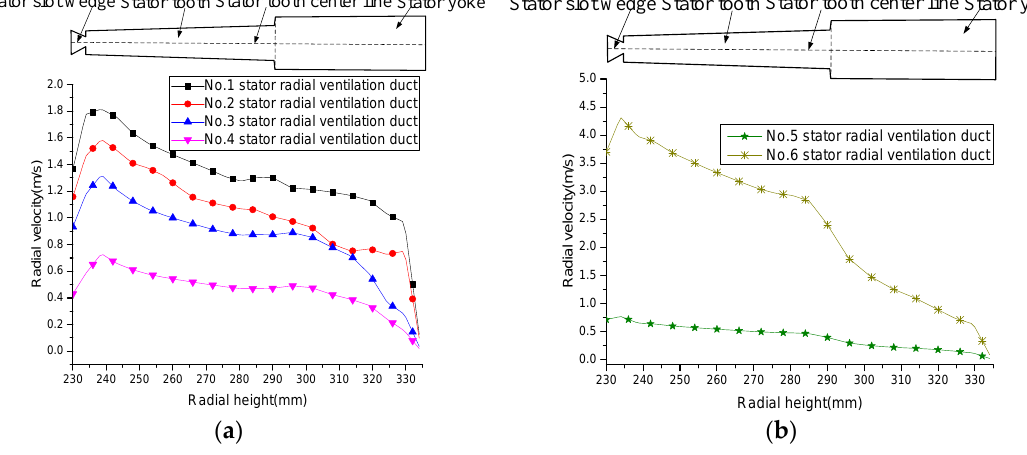
Figure 7. The changing trend of the radial flowing velocity of fluid: ( a ) No. 1, No. 2, No. 3, No. 4 stator radial ventilation duct; ( b ) No. 5, No. 6 stator radial ventilation duct.